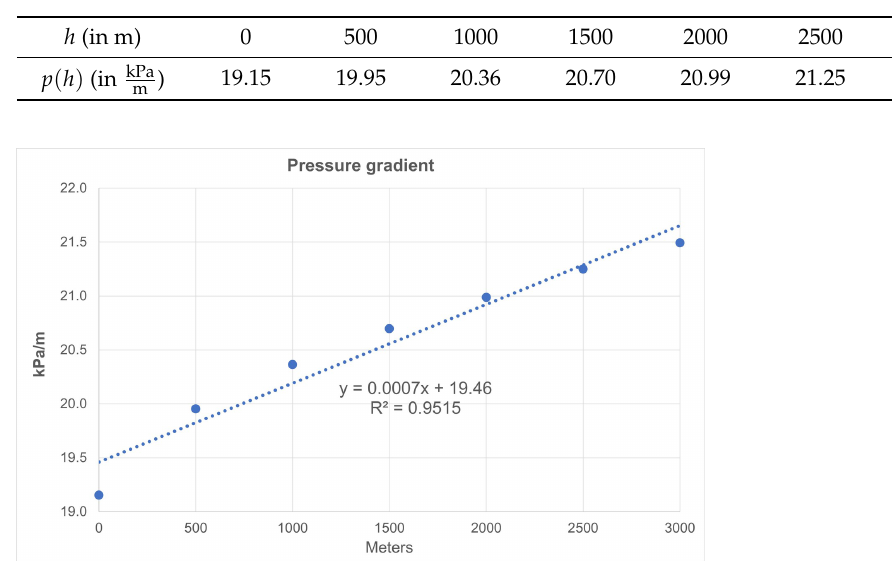
Table 1. Estimated values of the pressure gradient.